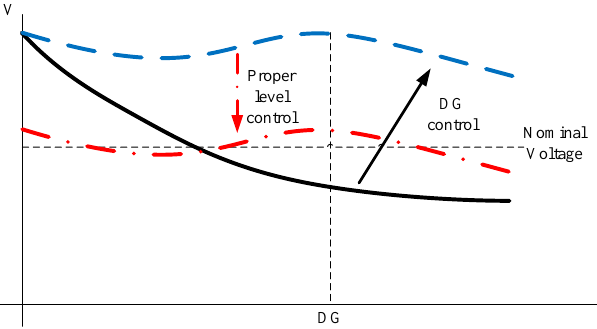
Figure 3. The proposed voltage control method for the nominal voltage.